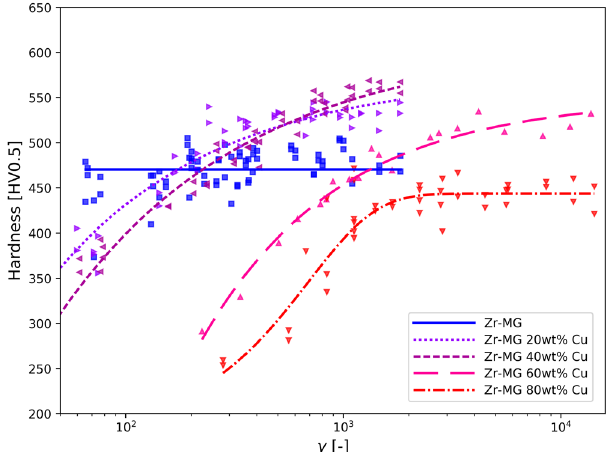
Figure 4. Illustration of Vicker’s hardness evolution as a function of the shear strain of all compositions and Zr-BMG. The hardness of Zr-MG is constant independently of the applied strain, but the hardness of all compositions increases with increasing strains. In the case of Zr-MG 80 wt% Cu, the hardness does not reach the hardness of Zr-MG, but all other compositions become harder than the two initial materials. The shape of the curve depends on the composition, higher contents of Cu shifts the curve to higher